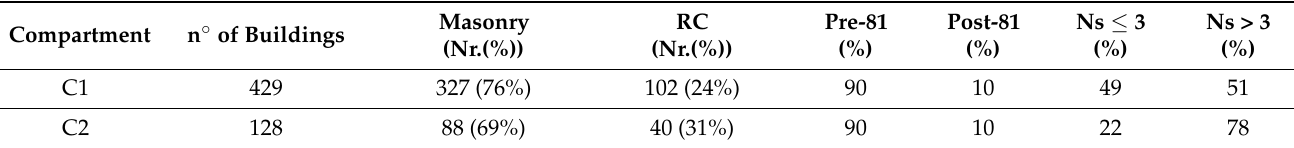
Table 1. Relevant data for the examined